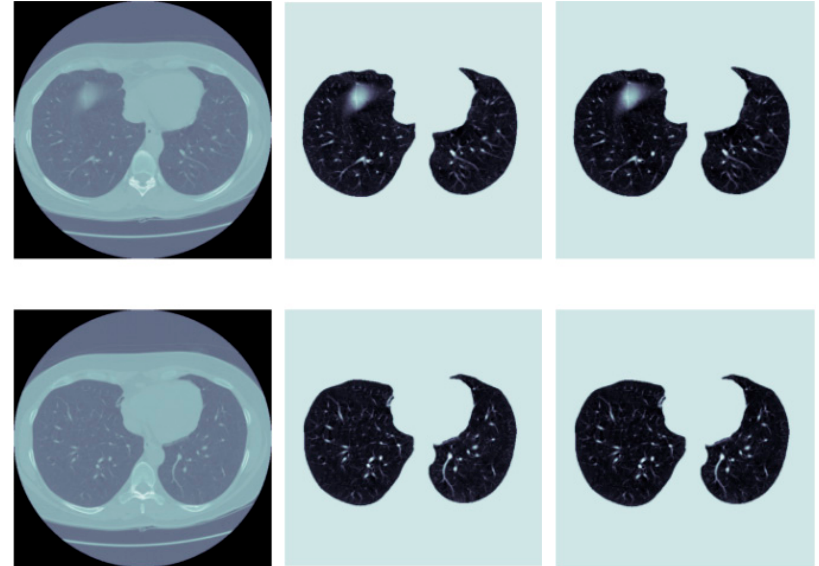
Figure 2. Comparison of CT segmentation effect.